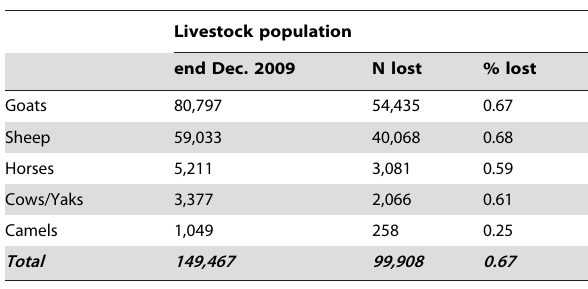
Table 1. Livestock losses in and around Great Gobi B Strictly Protected Area during the dzud winter 2009/2010 based on self-reported losses of 502 families.